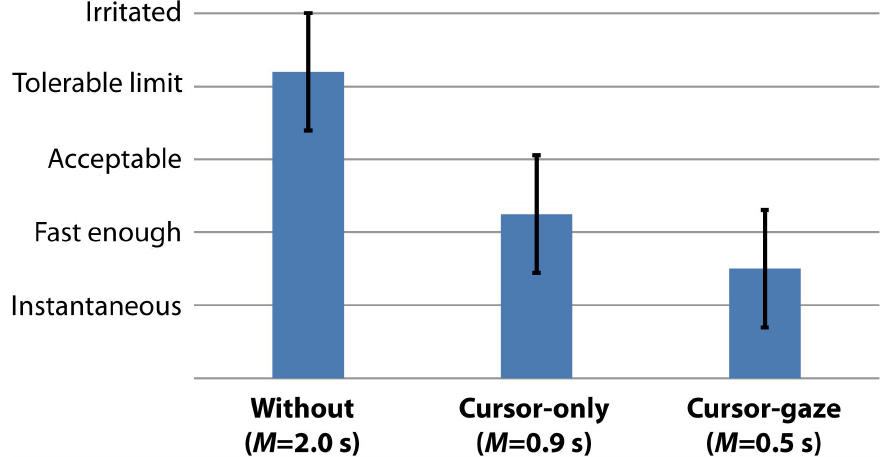
Figure 12. User perceived initial delay (lower is a faster